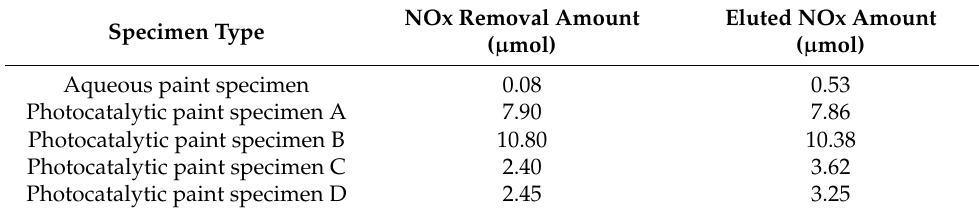
Table 8. Washing water field test results of five